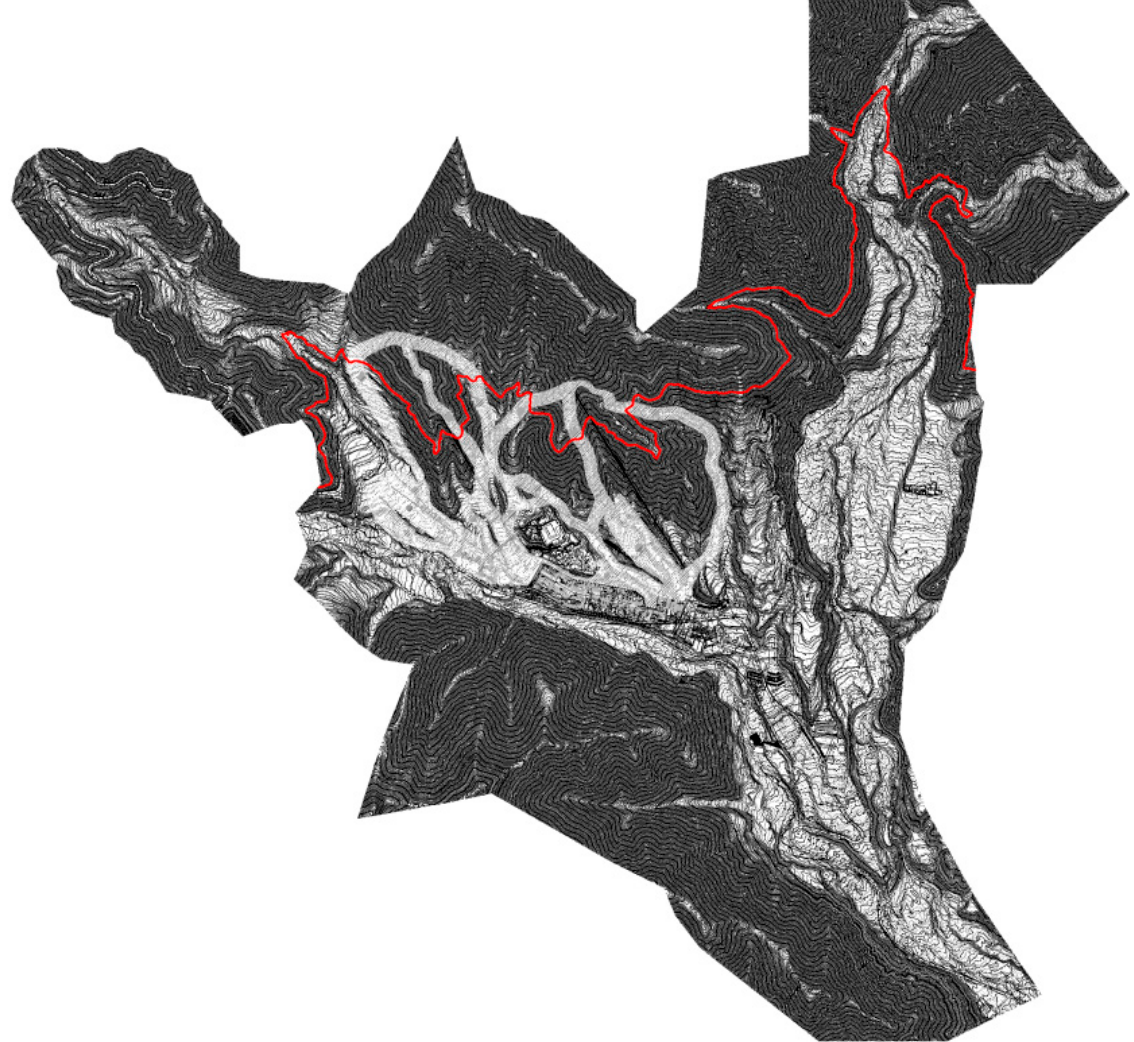
Figure 7. The selected contour line (marked as red in picture) of the digital model of the WTST.